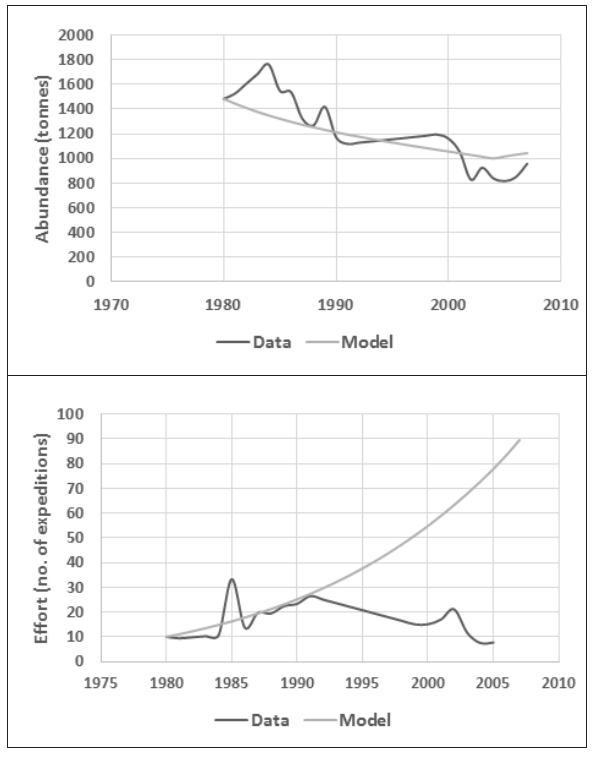
Figure 5: Sensitivity plots for (a) abalone abundance and (b) poaching